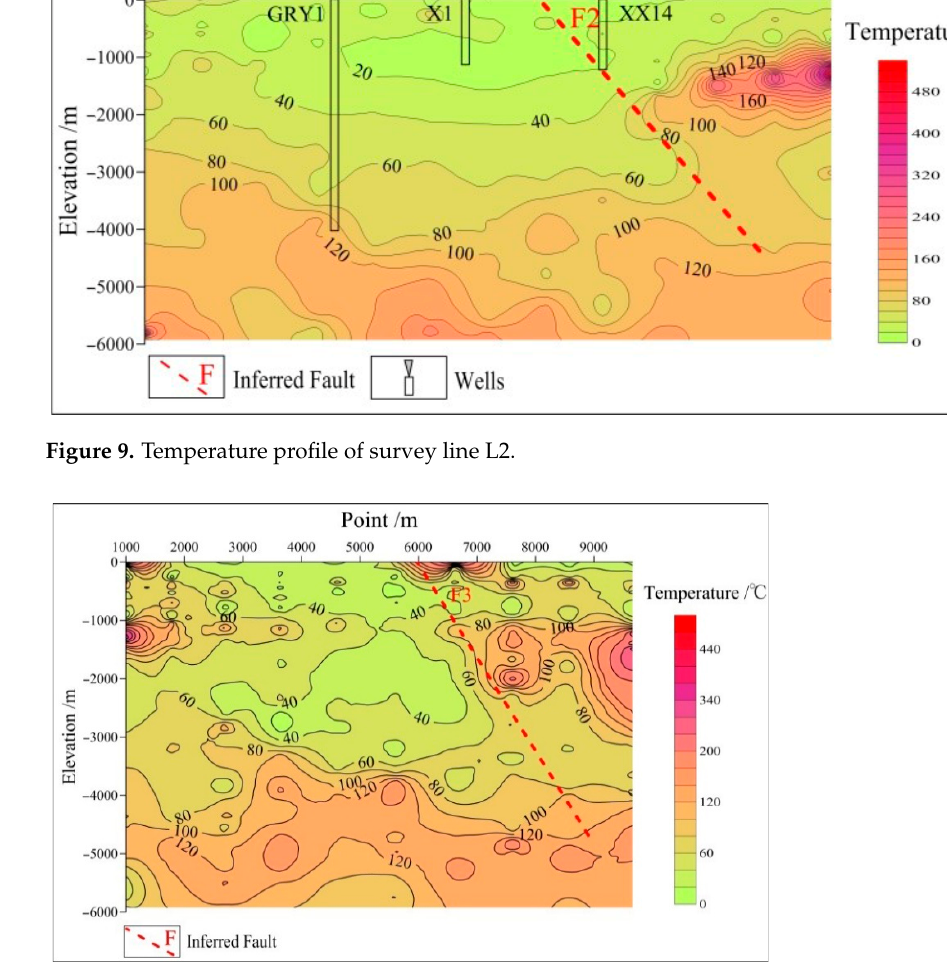
Figure 9. Temperature profile of survey line L2.